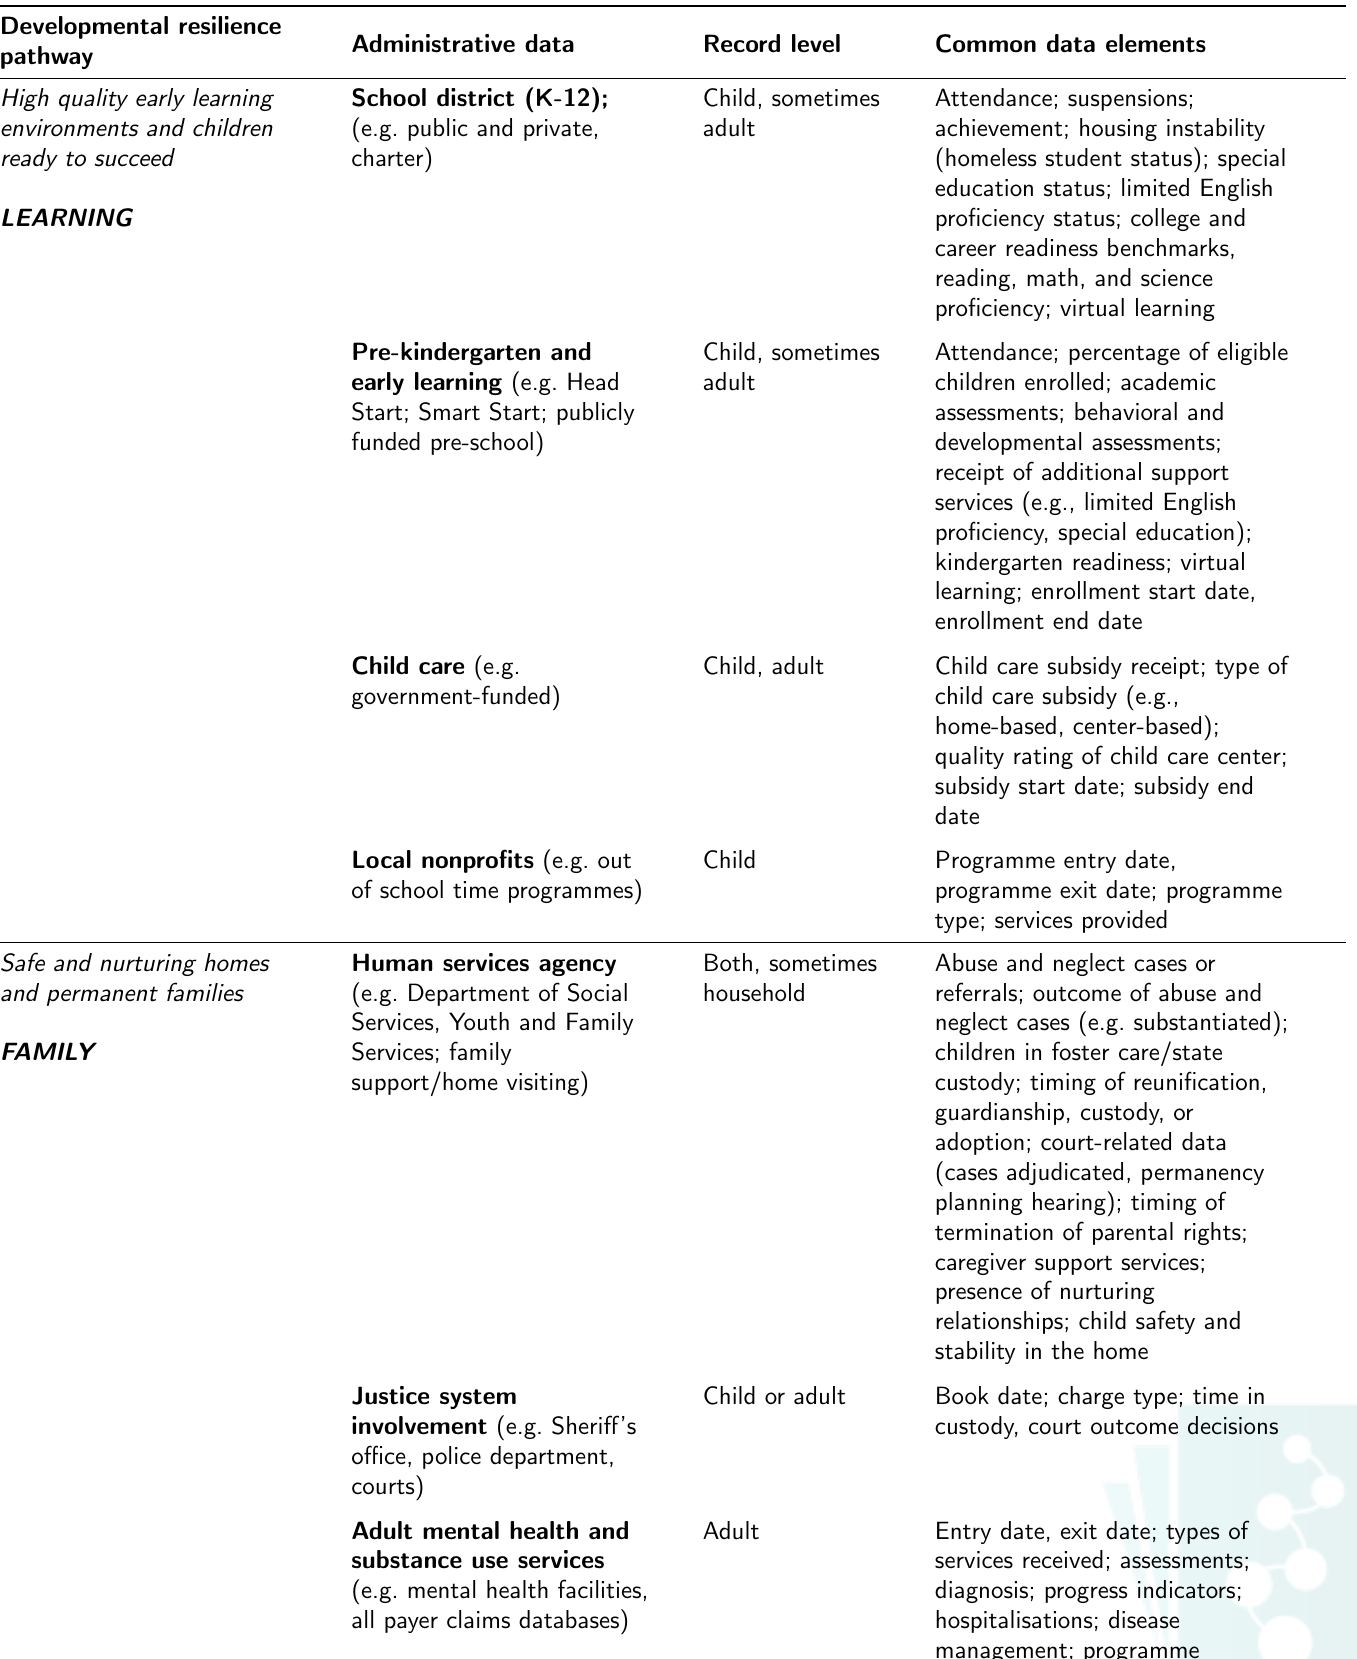
Table 1: IDS Capacities to study developmental resilience